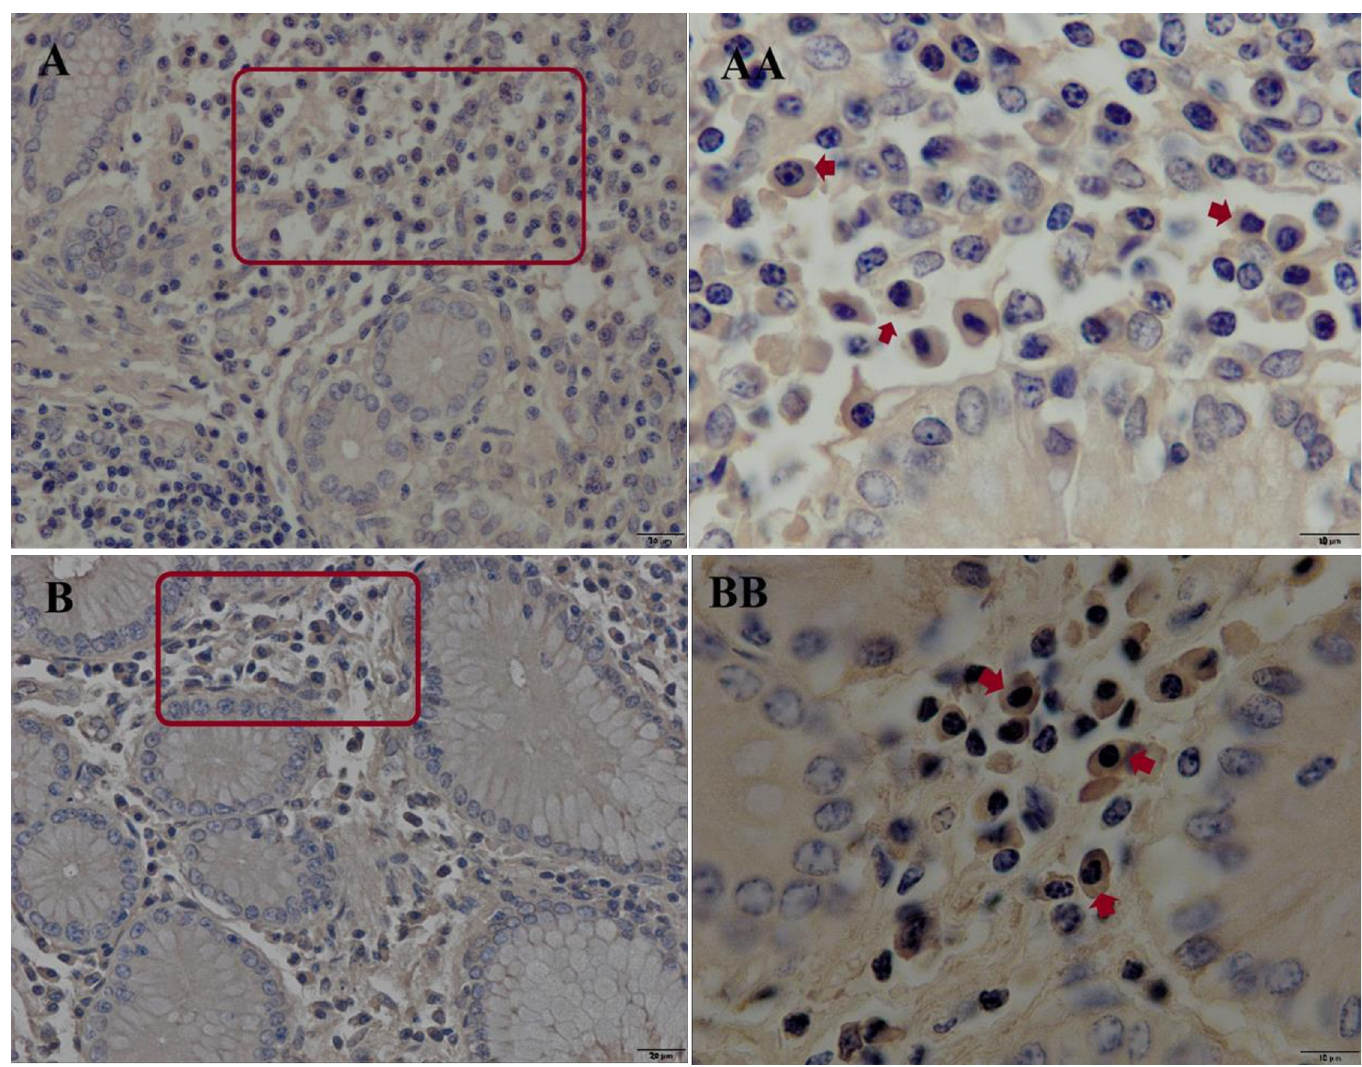
Fig 11. Immunohistochemical staining of IgG antibody-producing cells in the ALNA of young Dromedary camels. (A) Distribution of IgG APCs in longitudinal mucosal fold area; (B) Distribution of IgG APCs in reticular mucosal fold area. The IgG APCs were dispersed in the lamina propria among the gastric glands. Red rectangles are representative views from the two sublocations (Original magnification left column = 400 × , right column = 1000 × ). on the lymphoid nodes in the abomasum of Dromedary camel, whereas the ileal lymphoid nodes in the pig appeared as a band-like structure [34]. PPs are scattered throughout the small intestine in mice and contain 4–10 lymphoid nodules each, whereas the 30–80 aggregated lym- phoid nodules in the human small intestine contain 5–900 lymphoid nodes each [21]. Analo- gous to the anatomical location and gross appearance of the lymphoid nodule region in the stomach of the dromedary and Bactrian camel, the lymphoid follicles are confined to a trian- gular zone on the ventral surface of the third compartment along the minor curvature. The region consists of a reticular and longitudinal membranous fold with a clear border between the region with the clustered lymphoid follicles stomach of the Dromedary camel consisted of aggregated lymphoid follicles lying in a row in the sub-mucosa and varied in size and shape. However, the follicles are arranged in multiple rows in certain mucosal folds, analogous to the